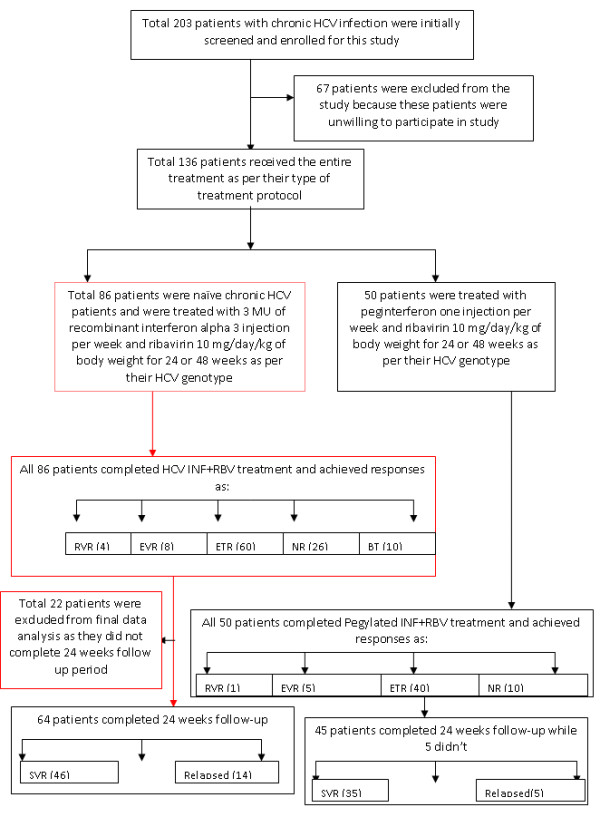
Patients disposition and treatment responses.